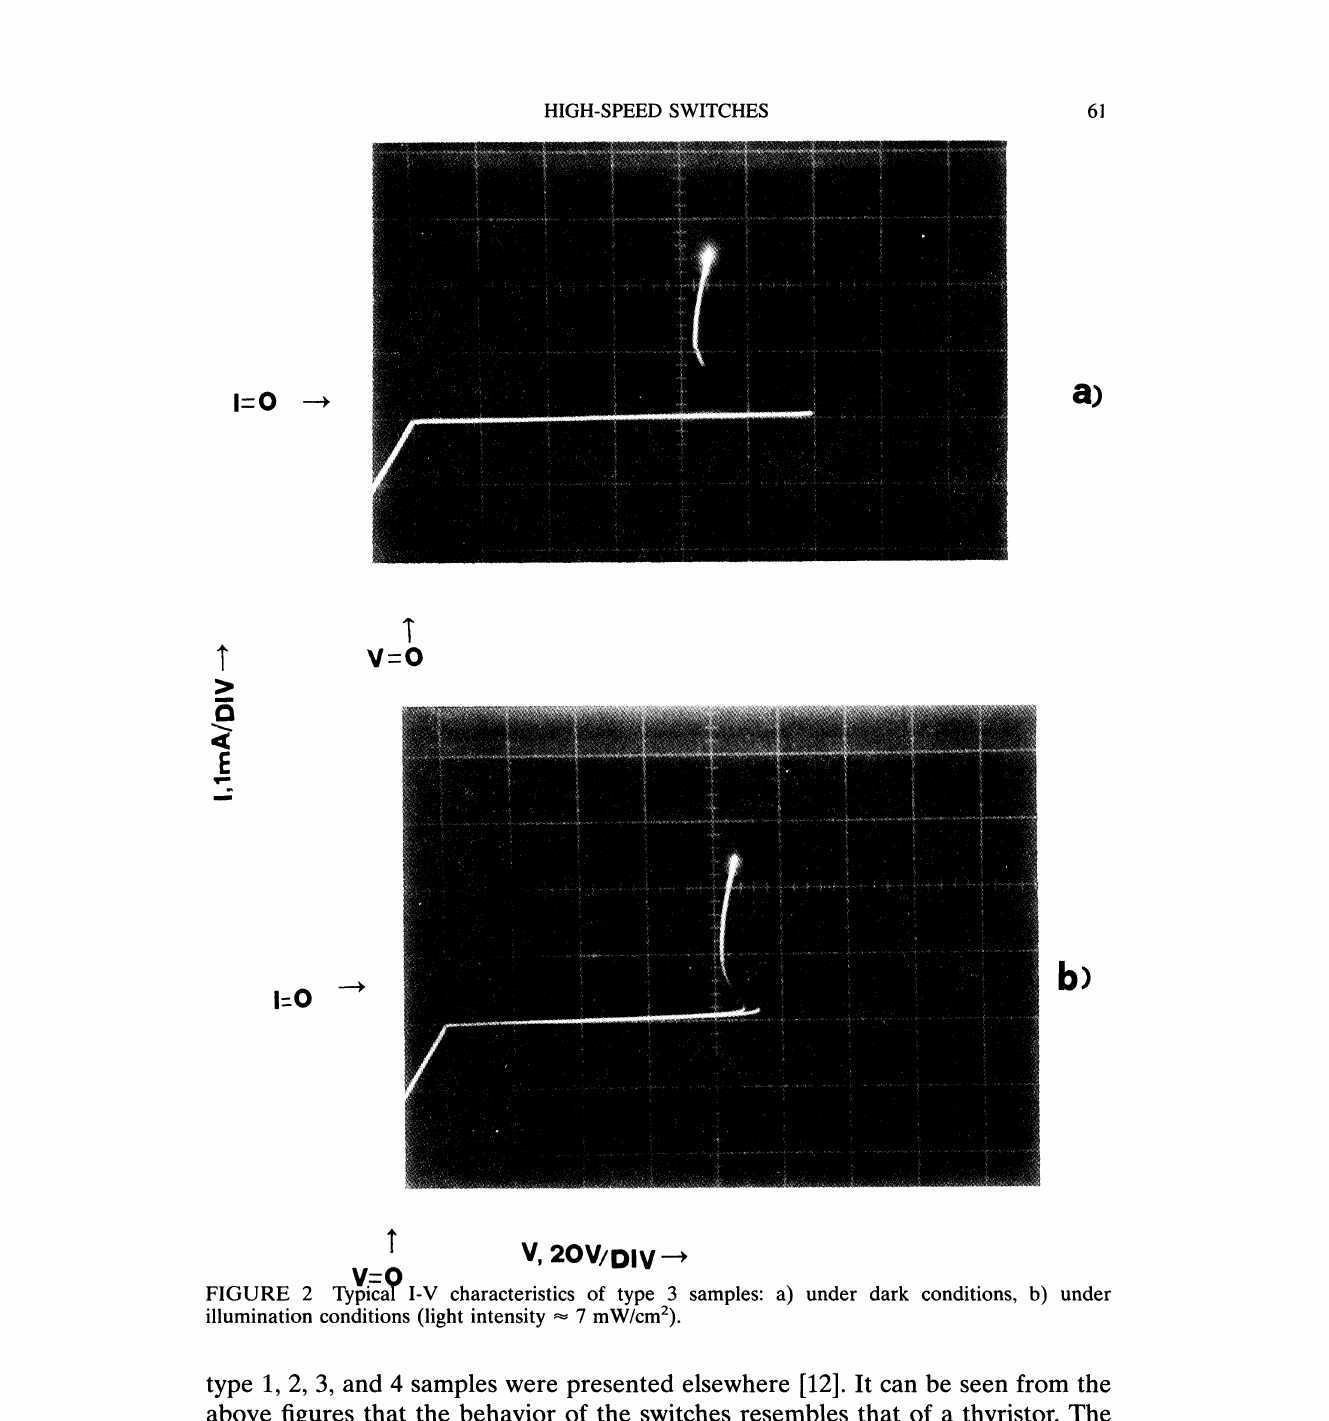
Ty;aY FIGURE 2 l-V characteristics of type 3 samples: a) under dark conditions, b) under illumination conditions (light intensity 7